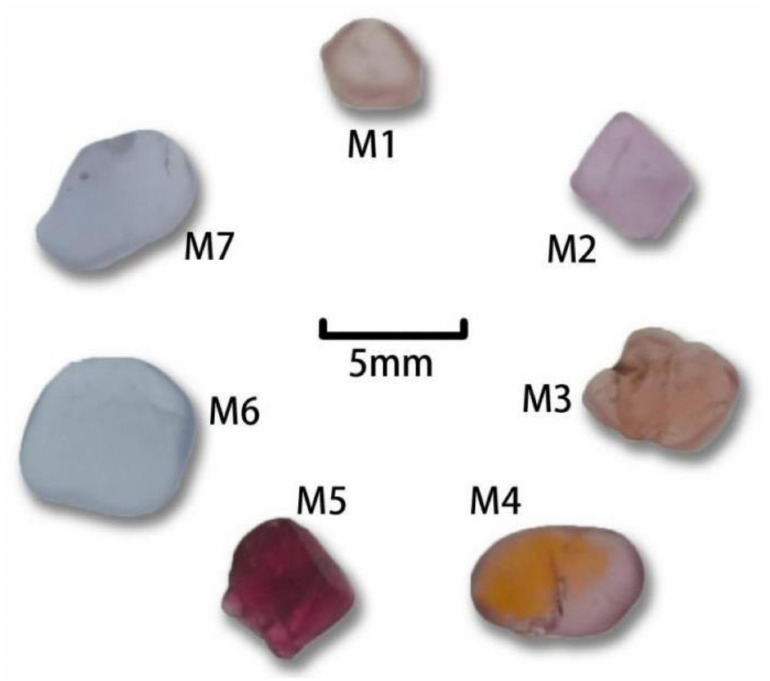
Figure 1. Spinel samples from